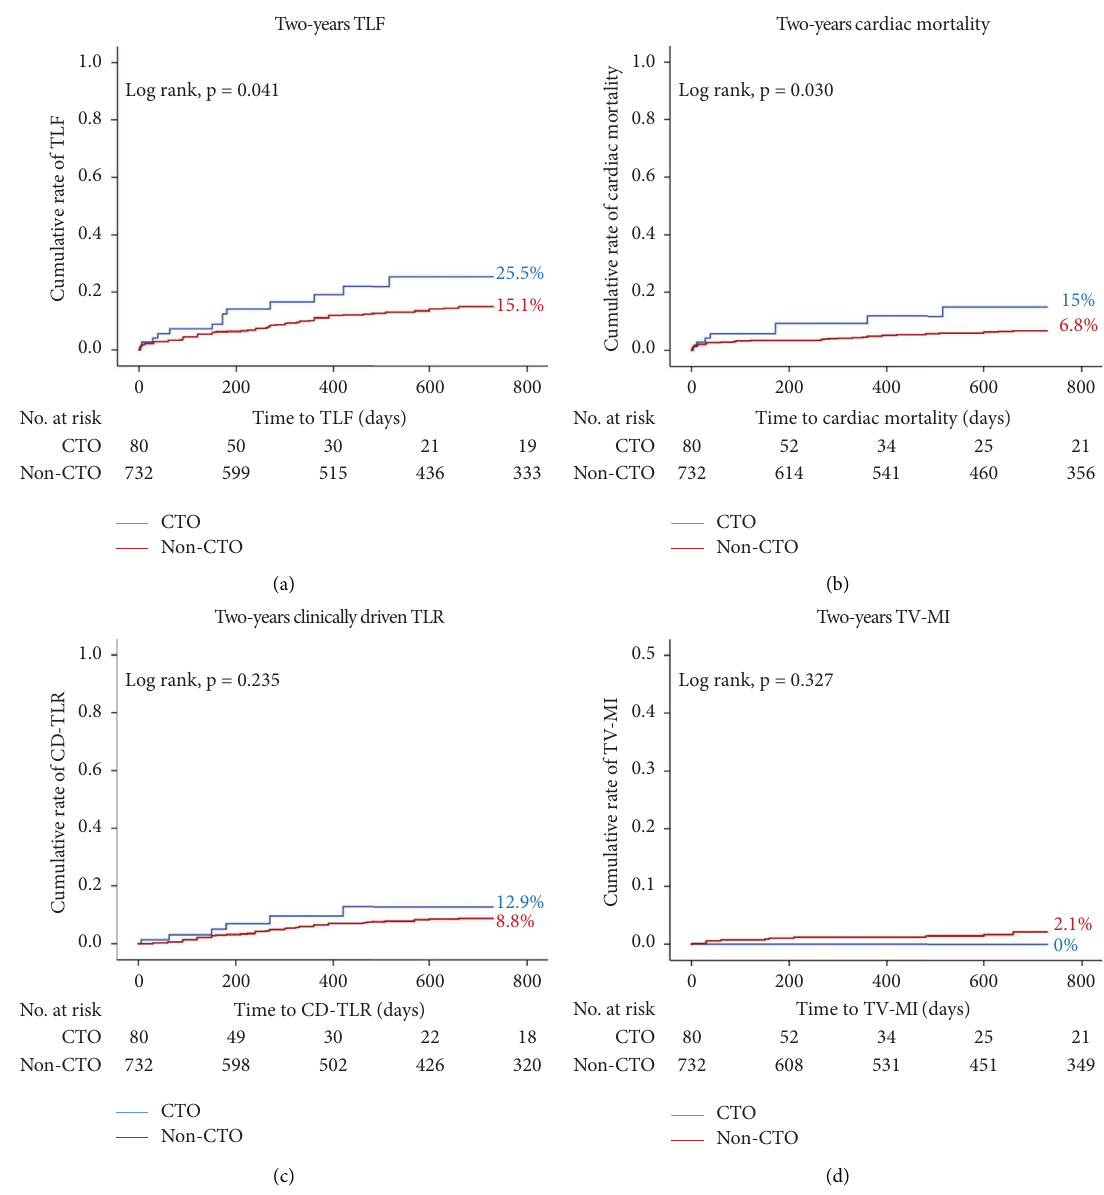
Figure 1: Kaplan–Meier curves of the two-year cumulative rate of the occurrence of the endpoint. (a) Te cumulative rate of the 2-year target lesion failure (TLF), (b) cardiac mortality, (c) clinically driven target lesion revascularisation (TLR), and (d) target vessel myocardial infarction (TV MI) between chronic total occlusion (CTO) and nonchronic total occlusion (non-CTO) deaths (15.0% vs 6.8%; log rank p = 0.030). Te 2-year target